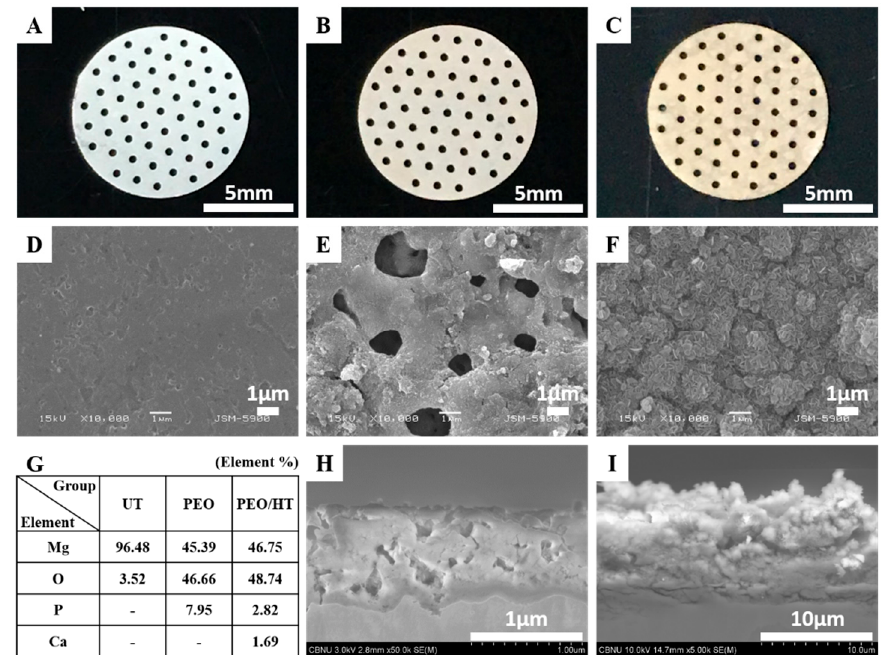
Figure 2. ( A ) Optical images of the untreated Mg mesh, ( B ) PEO-treated Mg mesh, ( C ) PEO/hydrothermal treatment (HT)-treated Mg mesh, ( D ) SEM surface morphologies of the untreated Mg mesh, ( E ) PEO-treated Mg mesh, ( F ) PEO/HT-treated Mg mesh, ( G ) chemical composition on the surfaces, ( H ) cross-sectional images of the PEO-treated Mg mesh, and ( I ) PEO/HT-treated Mg mesh.